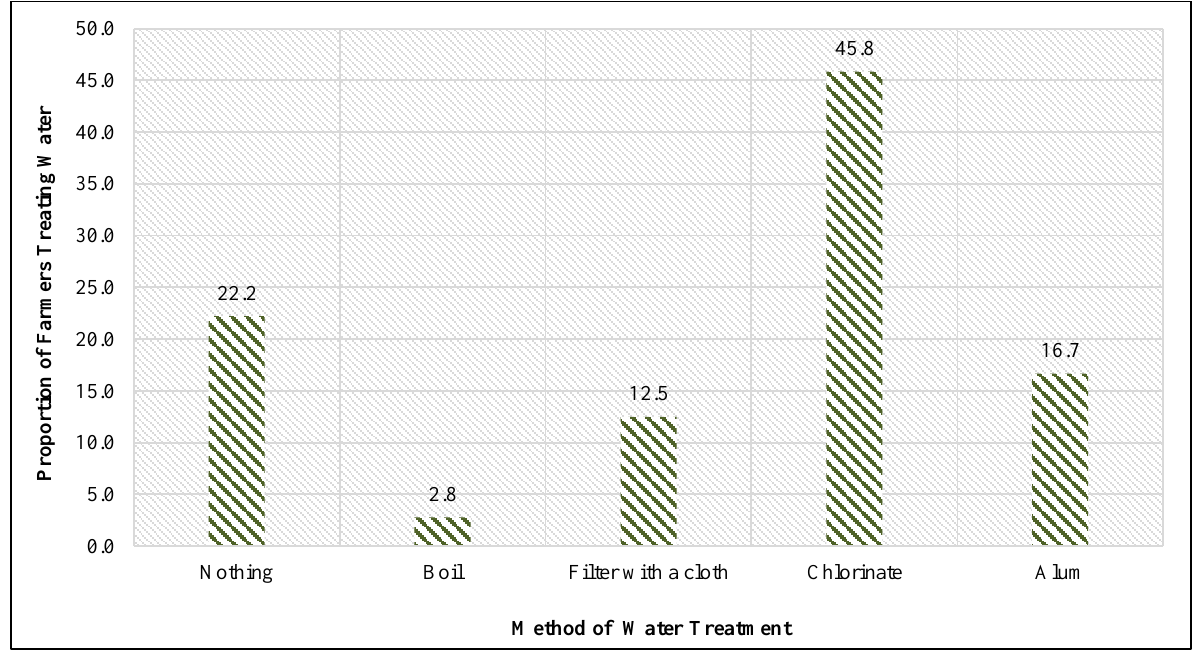
Figure 6. Proportion of different method of water treatment used by the farmers used in AIS